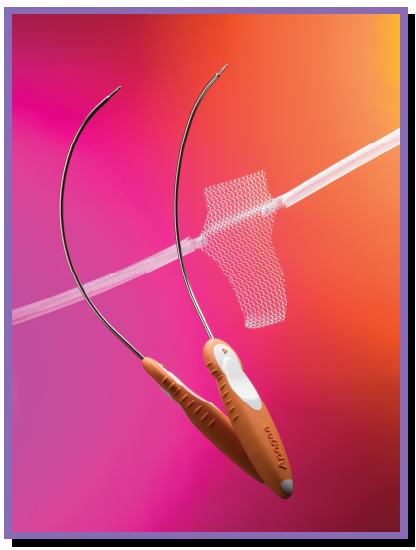
FIGURE 2. Apogee by American Medical